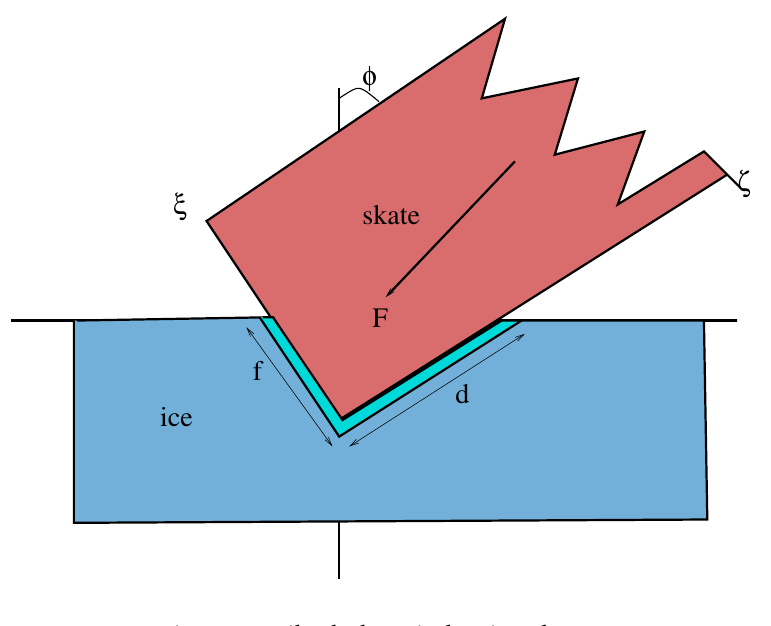
Figure 2: Tilted Skate indenting the